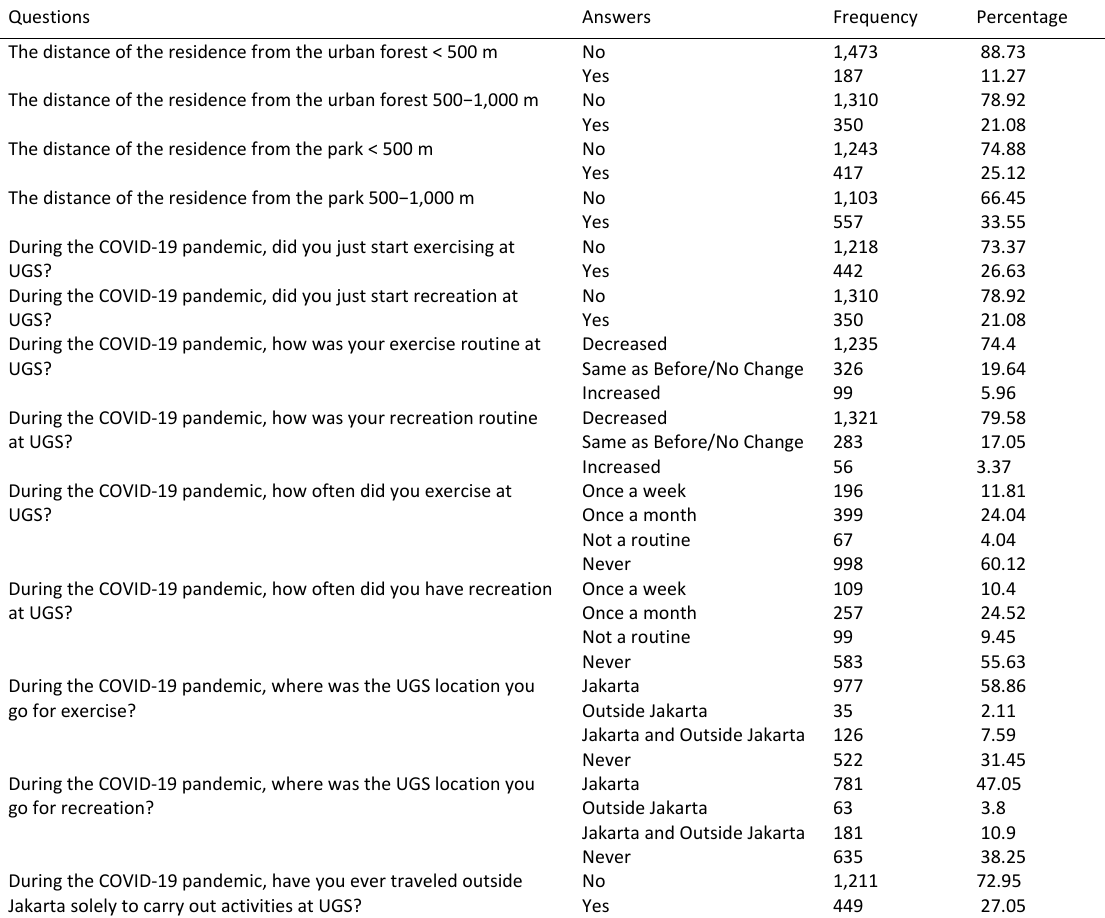
Table 2: Proximity to UGS and motivation for visitation